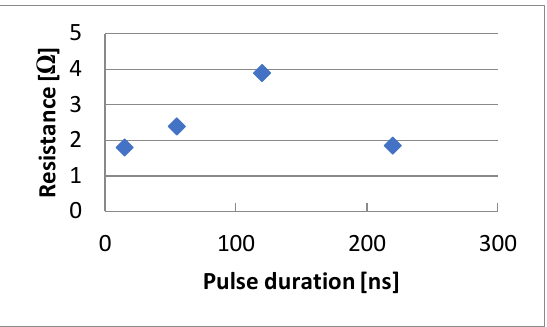
Figure 14. The dependence of resistance changes on the pulse duration.